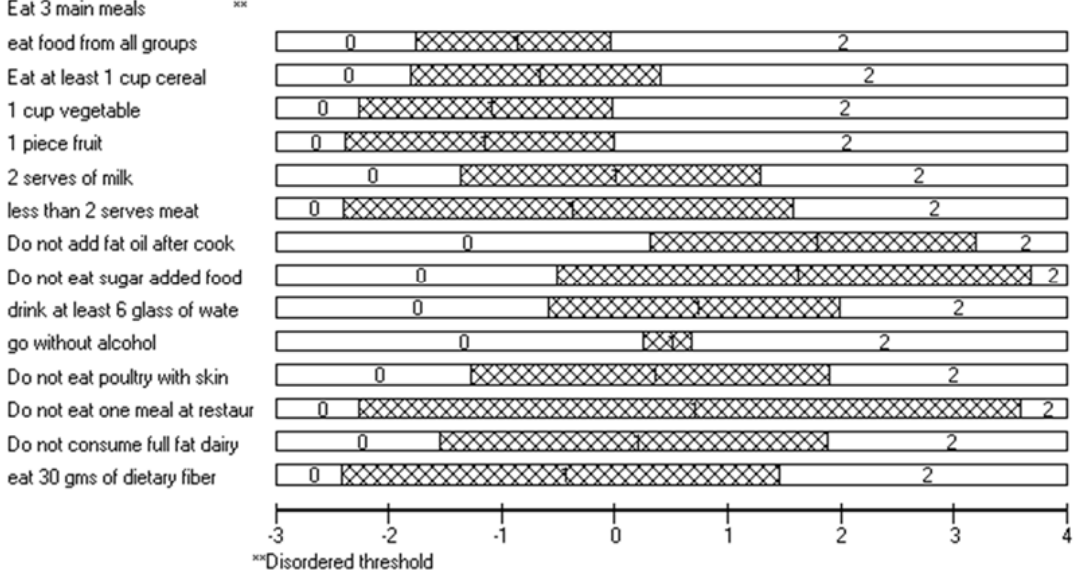
Figure 1. Threshold map for all items.